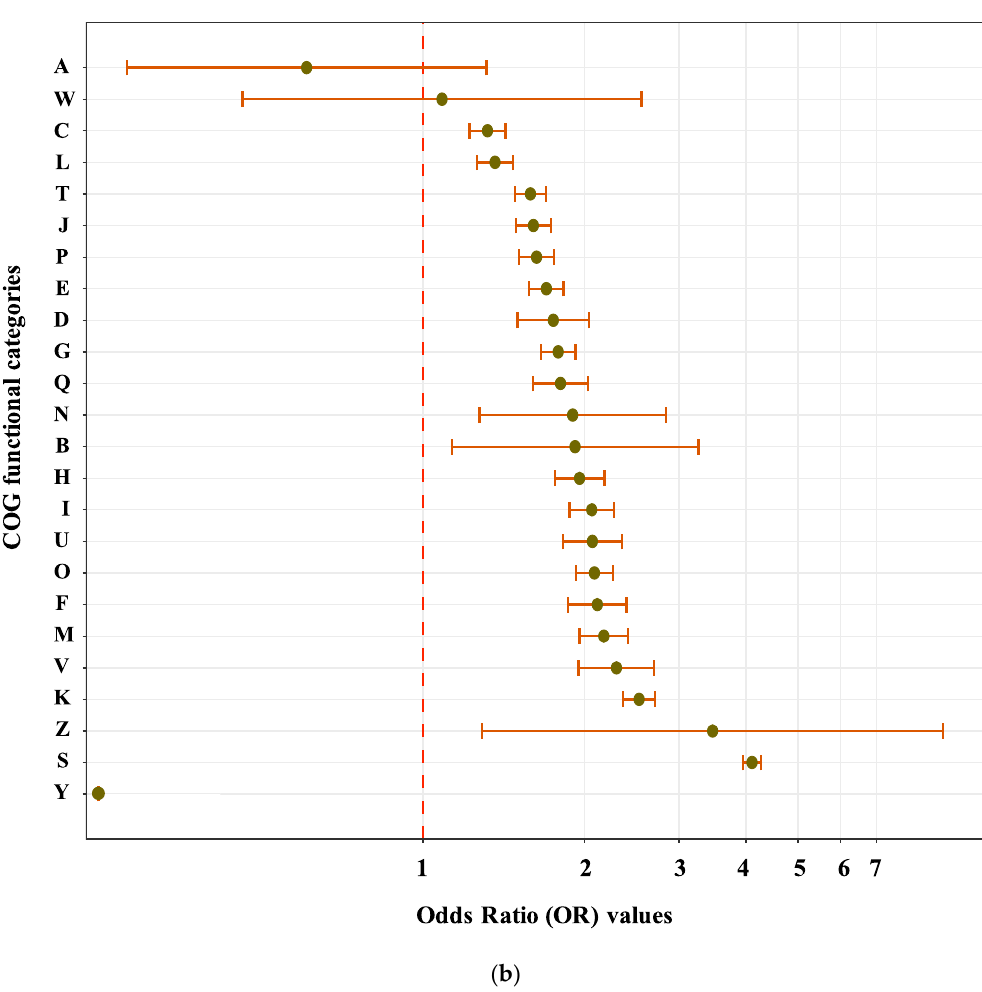
Figure 3. Function analysis of composite and non-composite genes. ( a ) Numbers of nested composite, strict composite, strict component, and non-remodelled genes across all COG categories. ( b ) Numbers of OR, upper 95% CI and lower 95% CI value (after Bonferroni correction) across all COG functions. The detailed numbers are shown in Table S1. There was not composite gene identified from prokaryote in category Y in this dataset, so OR test was not applied. Apart from A and W, which span 1.0, the odds of composite gene presence in all COG categories shows statistically significant tendency in